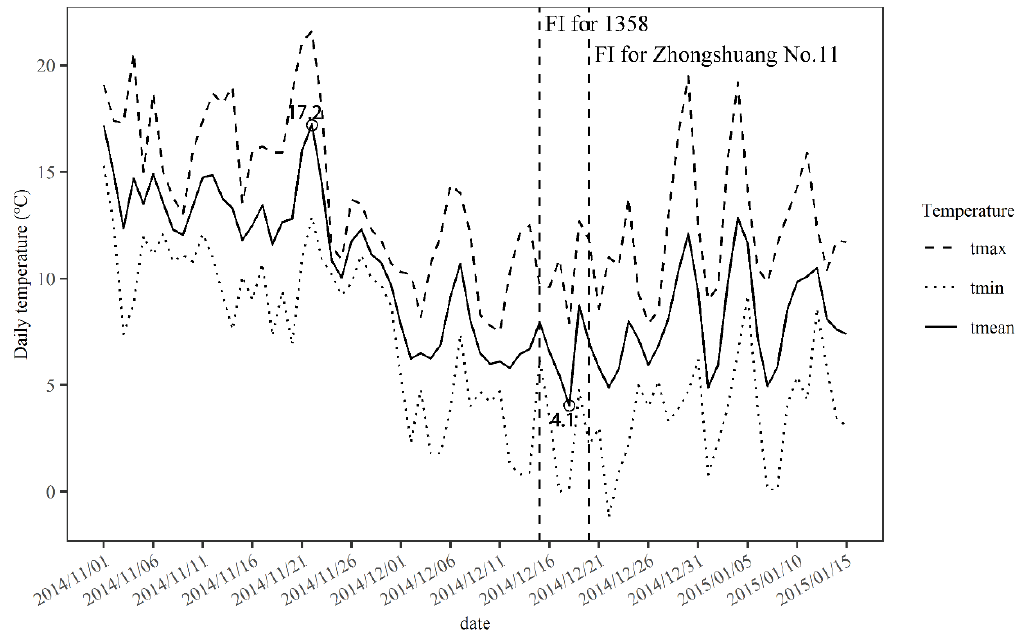
Figure 1. The daily maximum, mean, and minimum temperature during the period of Experiment 1. The dates indicated by the dotted vertical line on the x -axis correspond to the record date of floral initiation (FI) for these two varieties. The open circles indicate the maximum and minimum temperatures, respectively.